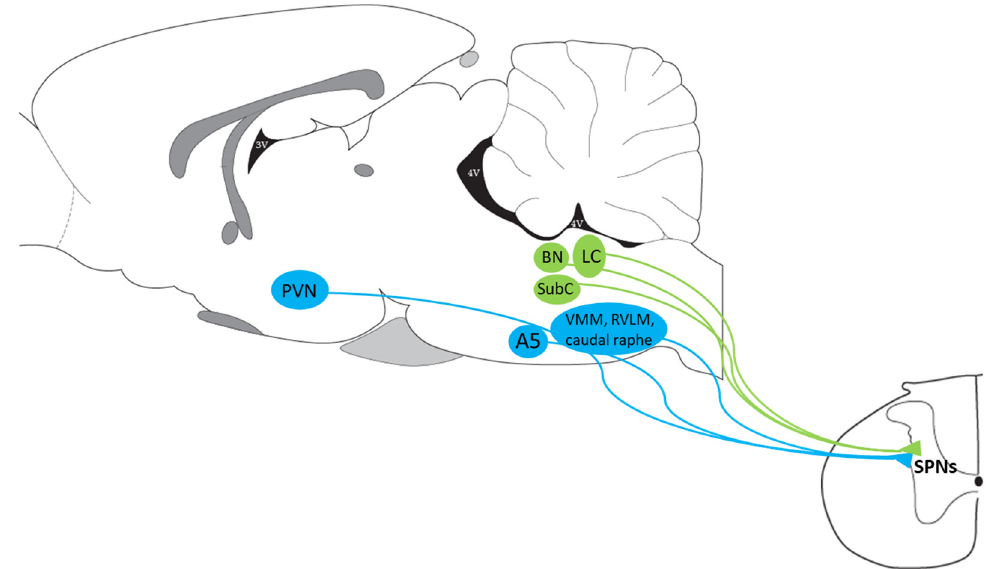
Figure 2. Presympathetic brain regions that project directly to the IML of the spinal cord where SPNs are located. Classical presympathetic areas are depicted in blue, whereas those in green are the regions we suggested to be added based on PRV neuronal tracing. For terms, see the list of abbreviations.